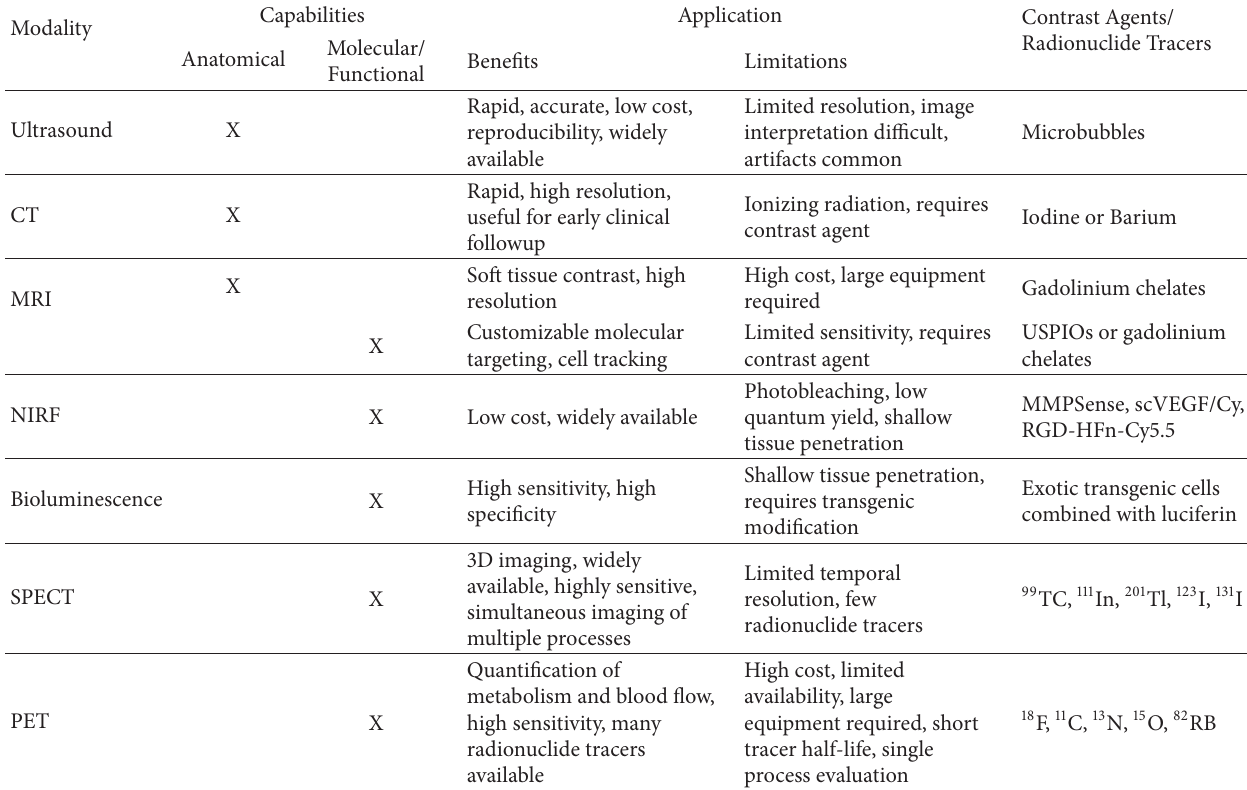
Table 1: Summary of imaging modalities used to image small animal abdominal aortic